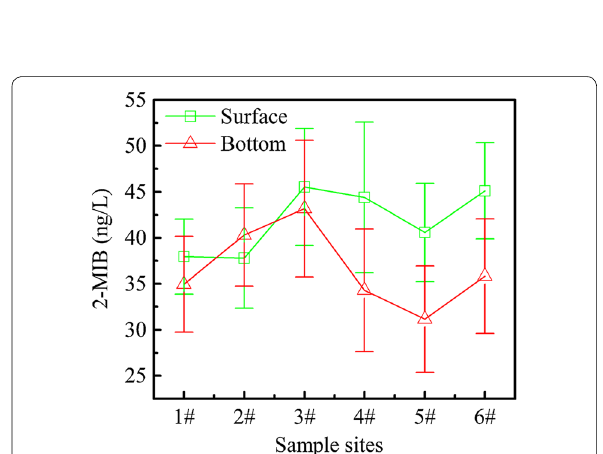
Fig. 7 2-MIB distribution in surface and bottom of different sites in SY